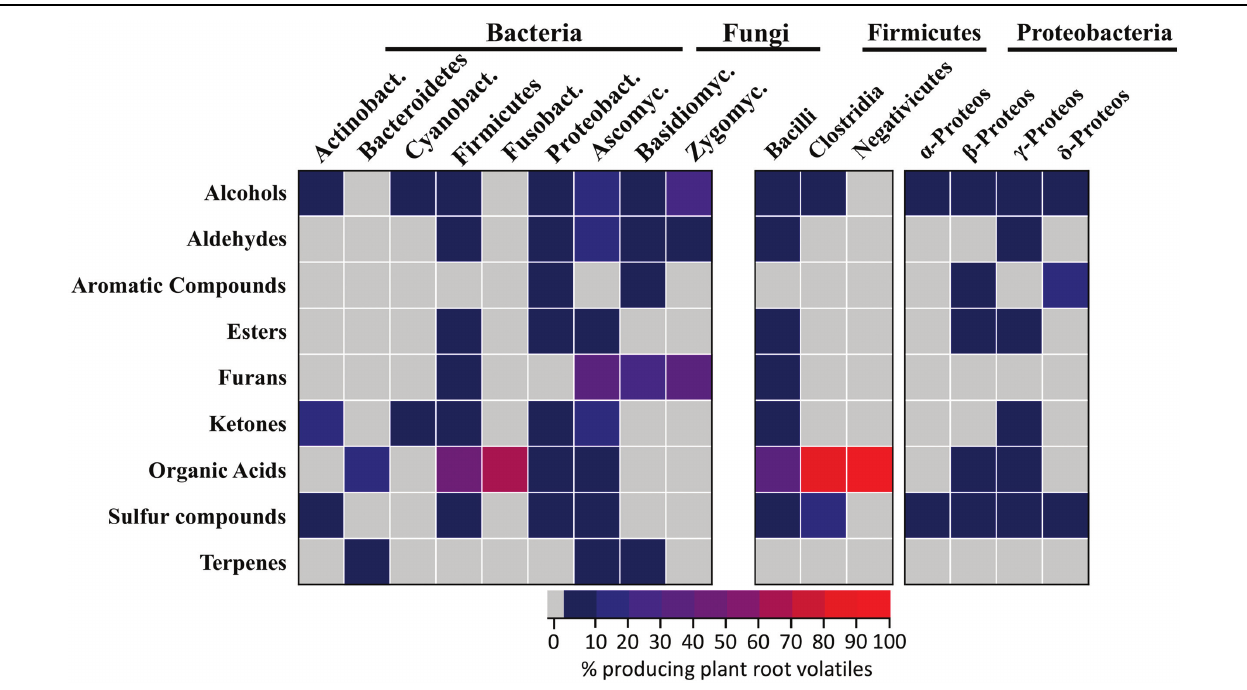
FIGURE 3 | Which microbes produce plant root volatiles? Bacteria and fungi producing the same volatiles as plant roots ( Figure 1 ) were identified from the mVOC database. The results are displayed for the different phyla or classes of bacteria and fungi as a heatmap where each cells represents the percentage of microbes emitting volatiles of Figure 1 . Actinobact: Actinobacteria ( n = 64), Bacteroidetes ( n = 44), Cyanobact: Cyanobacteria ( n = 19), Bacilli ( n = 11), Clostridia ( n = 10), Negativicutes ( n = 1), Fusobact: Fusobacteria ( n = 3), α -Proteos: α - Proteobacteria ( n = 25), β -Proteos: β - Proteobacteria ( n = 43), γ -Proteos: γ - Proteobacteria (n = 62), δ -Proteos: δ - Proteobacteria ( n = 17), Ascomyc: Ascomycota ( n = 104), Basidiomyc: Basidiomycota ( n = 28), Zygomyc: Zygomycota ( n =